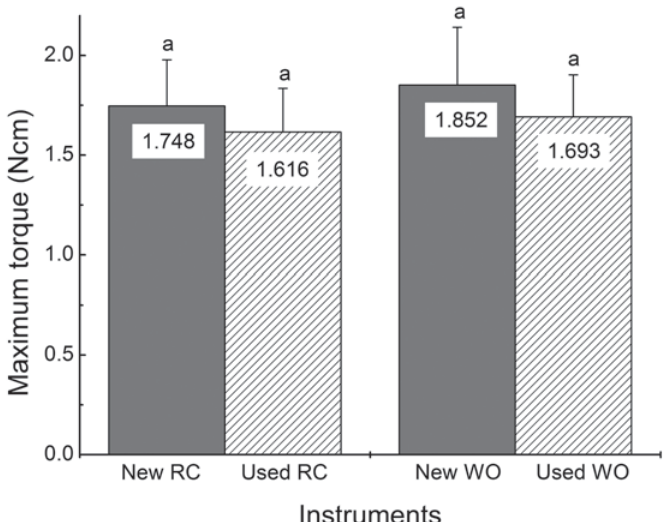
Figure 2- Mean values of maximum torque in torsion tested new and used RC and WO instruments (n=12 for each type); standard deviations shown as error bars. Bar values marked with the same letter were not statistically different